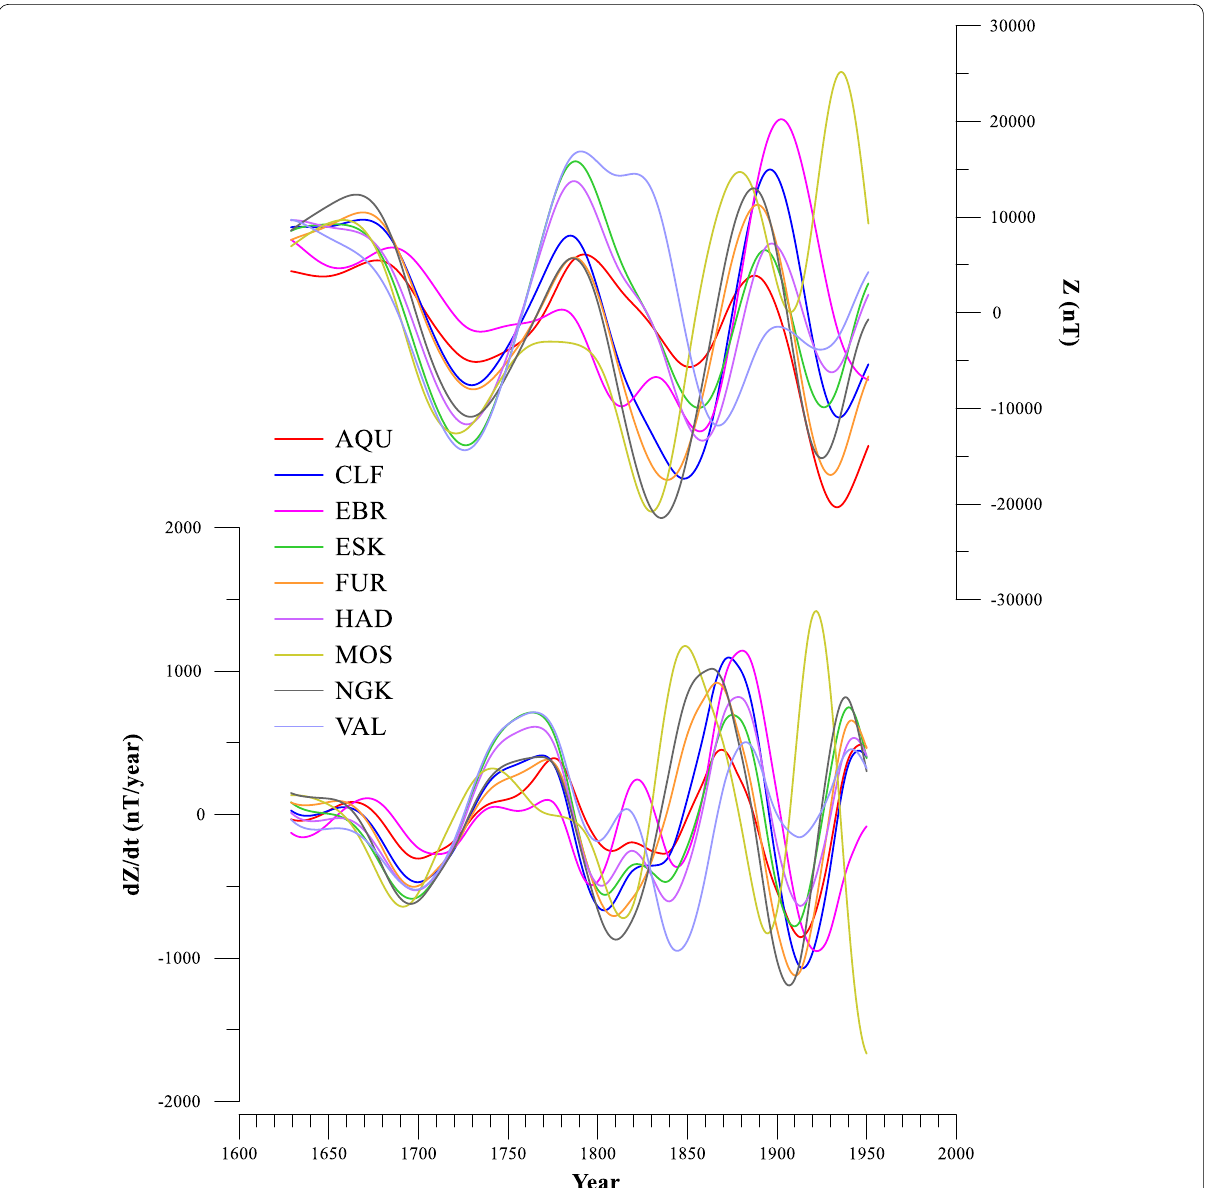
Fig. 1 Time series of the sub-centennial constituent (top) and their time derivative (bottom) of the core surface radial field for the location of nine European observatories (IAGA codes are associated with various line